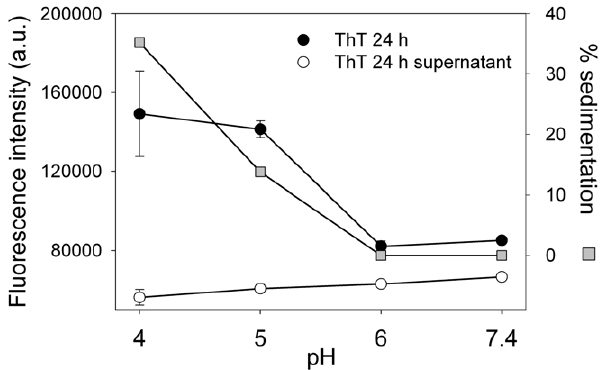
Figure 3. Binding of ThT to apoA-I. ApoA-I was incubated at pH 4.0, 5.0, 6.0 or 7.4 at a final concentration of 0.2 mg/mL at 37 u C for 24 h. One m l of ThT (1 mM) was added to each well and ThT fluorescence was measured in a plate reader at 480 nm (excitation at 430 nm) (black circles). Samples were then centrifuged (800 x g for 10 min) and ThT fluorescence remaining in the supernatant (empty circles) was measured. The amount of protein sedimented (gray squares) was calculated as the percentage of the initial protein (20 m g) remaining in